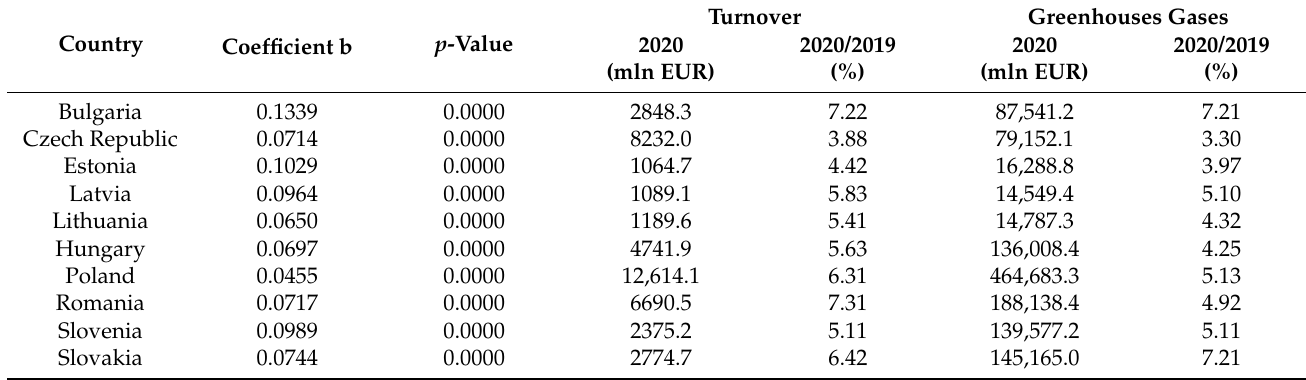
Table 5. Results from regression analysis and estimates of turnover value and GHG emissions in 2020 (with GDP growth forecast for 2020 from Autumn 2019).